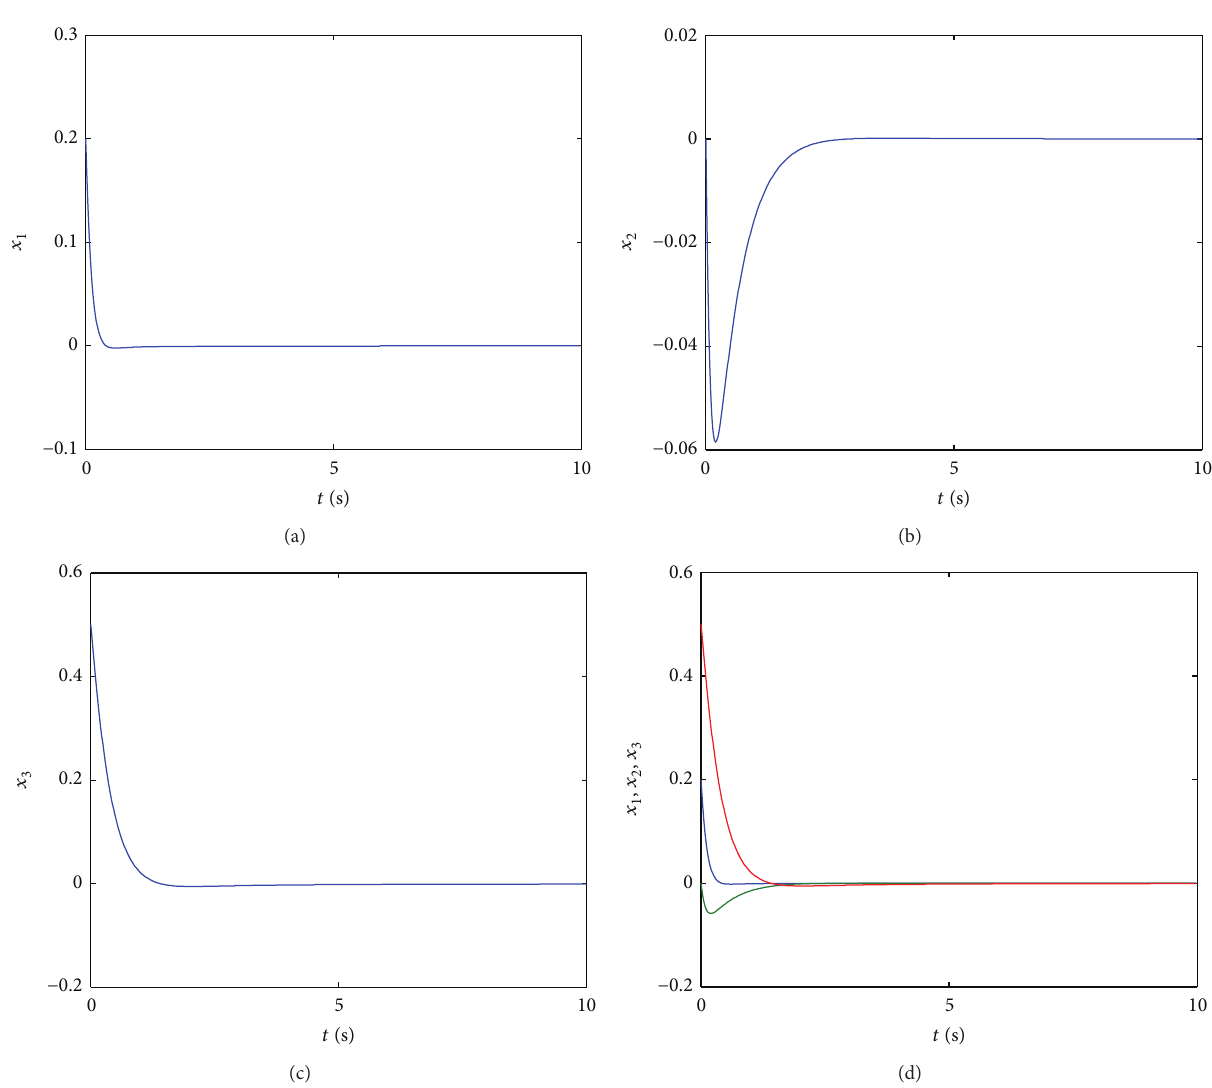
which satisfies the conditions Re ( eig ( A )) < 0 and 𝜔 = − max Re ( eig ( A )) = 2 > Γ(𝛼) = 0.9735 in Theorem 15.